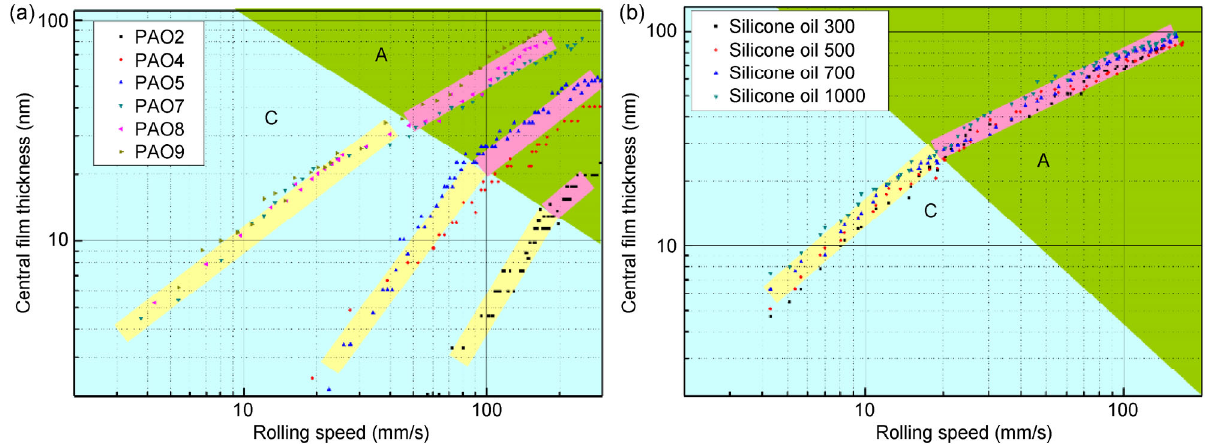
Fig. 12 Film formation of (a) PAO oil and (b) silicone oil obtained at high pressure of 3GPa by Xiao et al. [88].